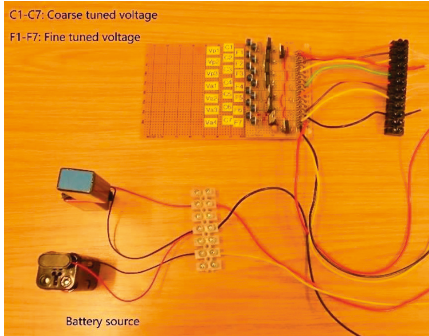
Figure 8: Voltage regulator circuit.